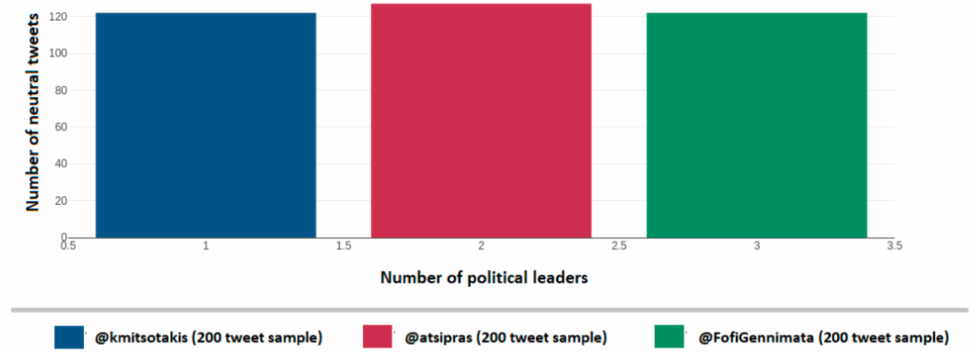
Figure 28. Neutral identified tweets for the top three Greek pollical leaders (600 tweet sample). Figure 29 depicts the identified tweets that indicate neutral mood per political account on Twitter namely for Kyriakos Mitsotakis (@kmitsotakis), Alexis Tsipras (@atsipras), and Fofi Gennimata (@FofiGennimata). Axis y depicts the number of identified neutral mood tweets over the 200-tweet sample, while the x axis depicts the number of political leaders.